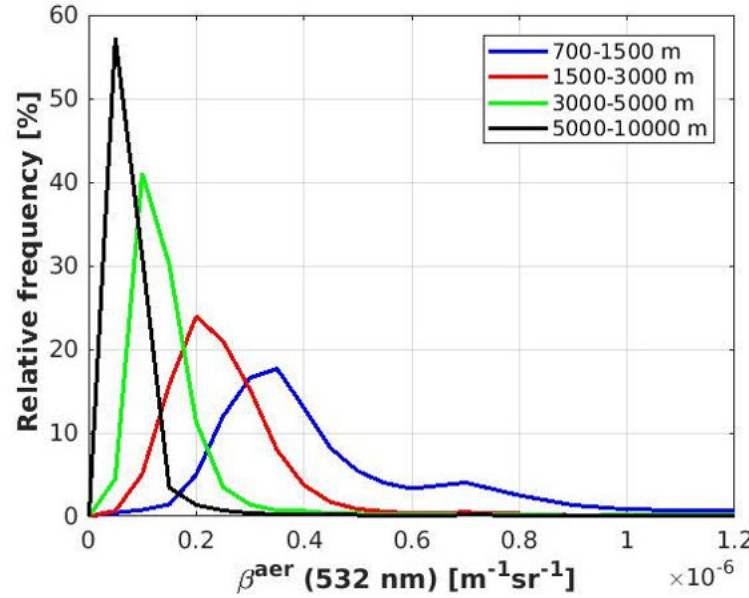
Figure 4. January–April: Frequency of β 532 .